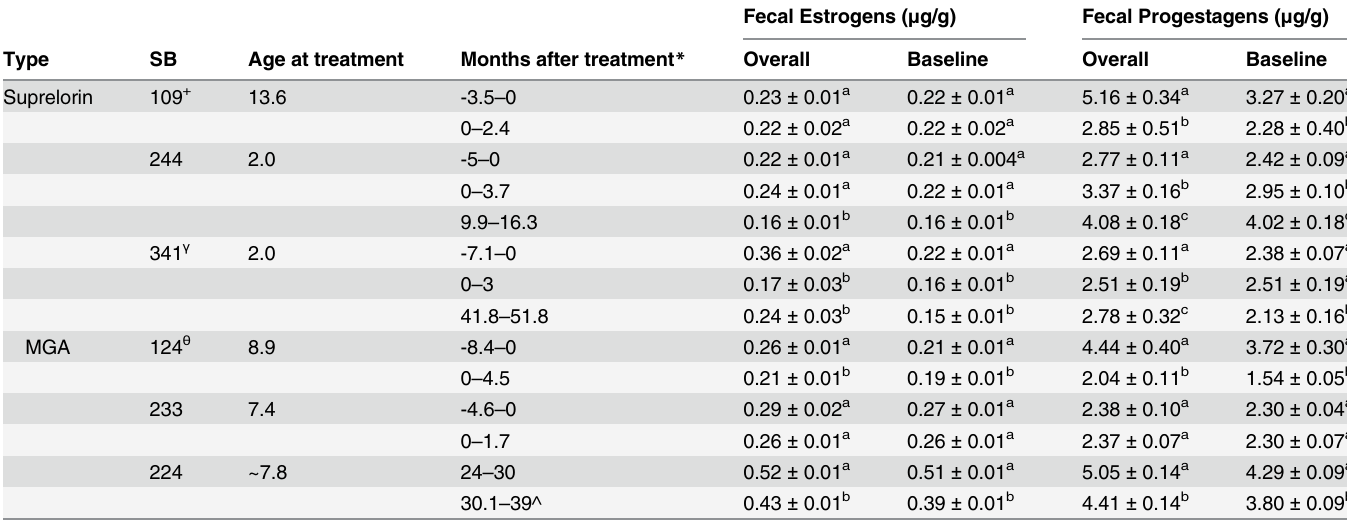
(Table 2; e.g., SB124, Fig 5C) and one (SB224) during MGA (collections began ~2 yr after implant was placed) and after implant removal (Fig 5D). In SB124, mean and baseline FEM = 6.47; P = 0.01 and F = 5.01; P = 0.03, respectively), concentrations decreased ( F 1,176 1,151 = 1.50; P = 0.23) or baseline whereas no changes were observed for SB233 in mean ( F 1,64 Table 2. Overall and baseline mean ( ± SE) concentrations of fecal estrogens before and after Suprelorin and MGA contraception treatments. Fecal Estrogens ( μ g/g) Fecal Progestagens ( μ